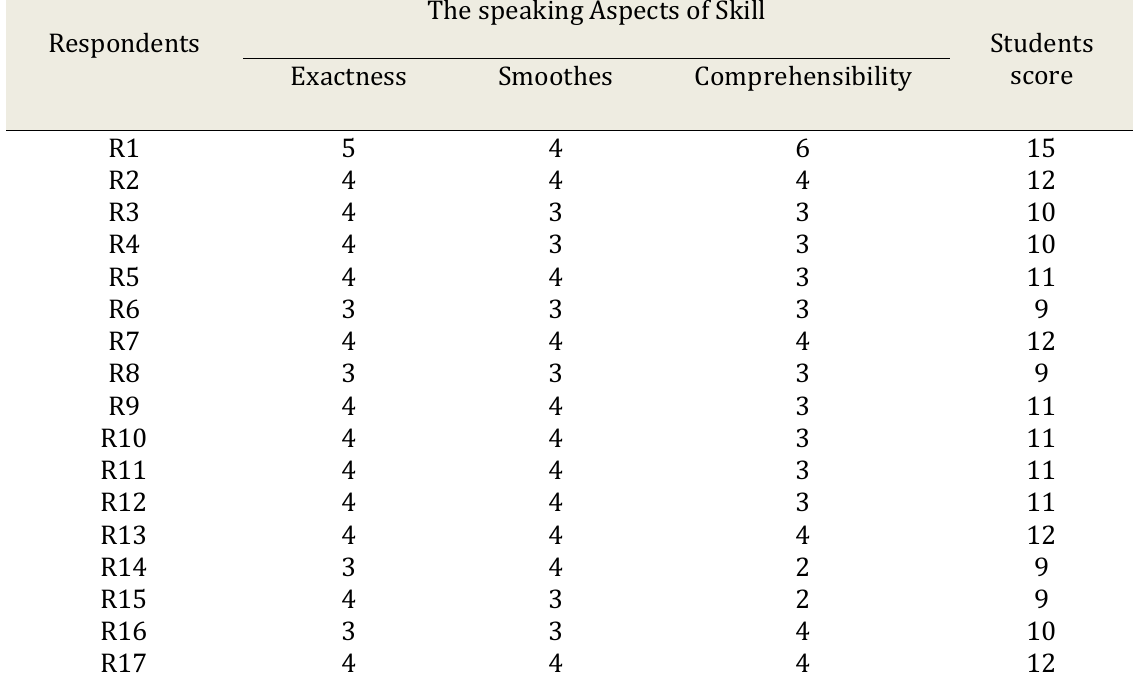
Table 4.8 The Students' Score Posttest Result in Experimental